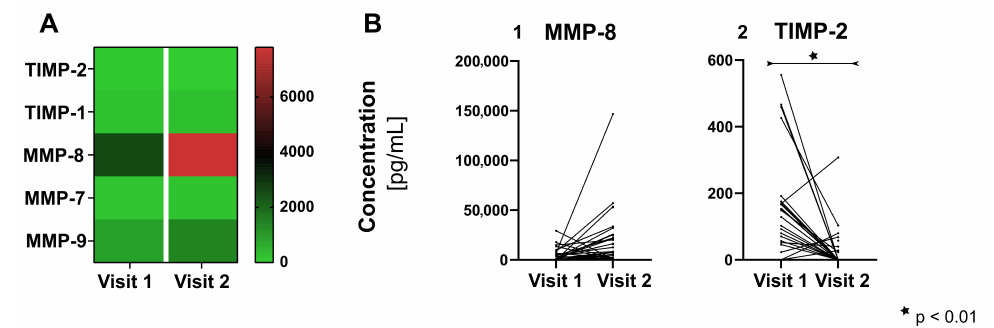
Figure 3. Changes in the concentrations of the matrix metalloproteinases (MMP) and tissue inhibitors of metalloproteinases (TIMP) from visit 1 to visit 2 for all groups. ( A ) Heatmap giving an overview Figure 3. Relevant geometrical parameters of the robot. over the medians and and ( B ) diagrams on the single-sample level for concentrations of MMP-8 (Graph 1 of Figure 2B) and TIMP-2 (Graph